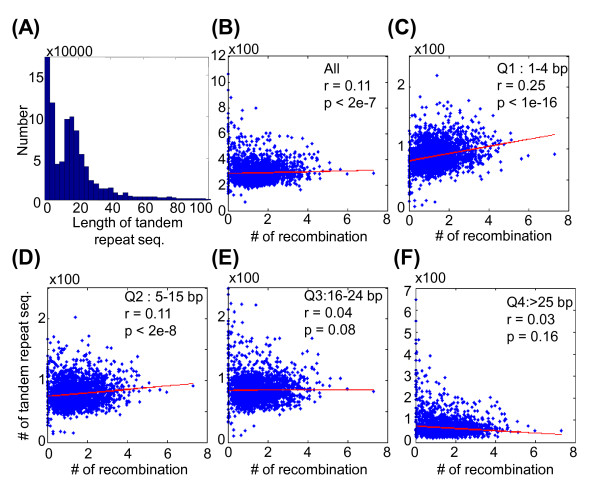
(A) Distribution of the length of the 947,696 tandem repeats sequences. (B) Scatter plot of the number of maternal recombination sites and the number of tandem repeat sequences. When the tandem repeat sequences are grouped into 4 quartiles according to the length of repeat sequences, scatter plots for each quartile are shown in (C) Q1, 1-4 base pairs (bp), (D) Q2, 5-15 bp, (E) Q3, 16-24 bp, and (F) Q4, larger than 25 bp, respectively. Regression lines are marked in red, and the Pearson correlation coefficients between number of maternal recombination events and the number of tandem repeat sequences are indicated.